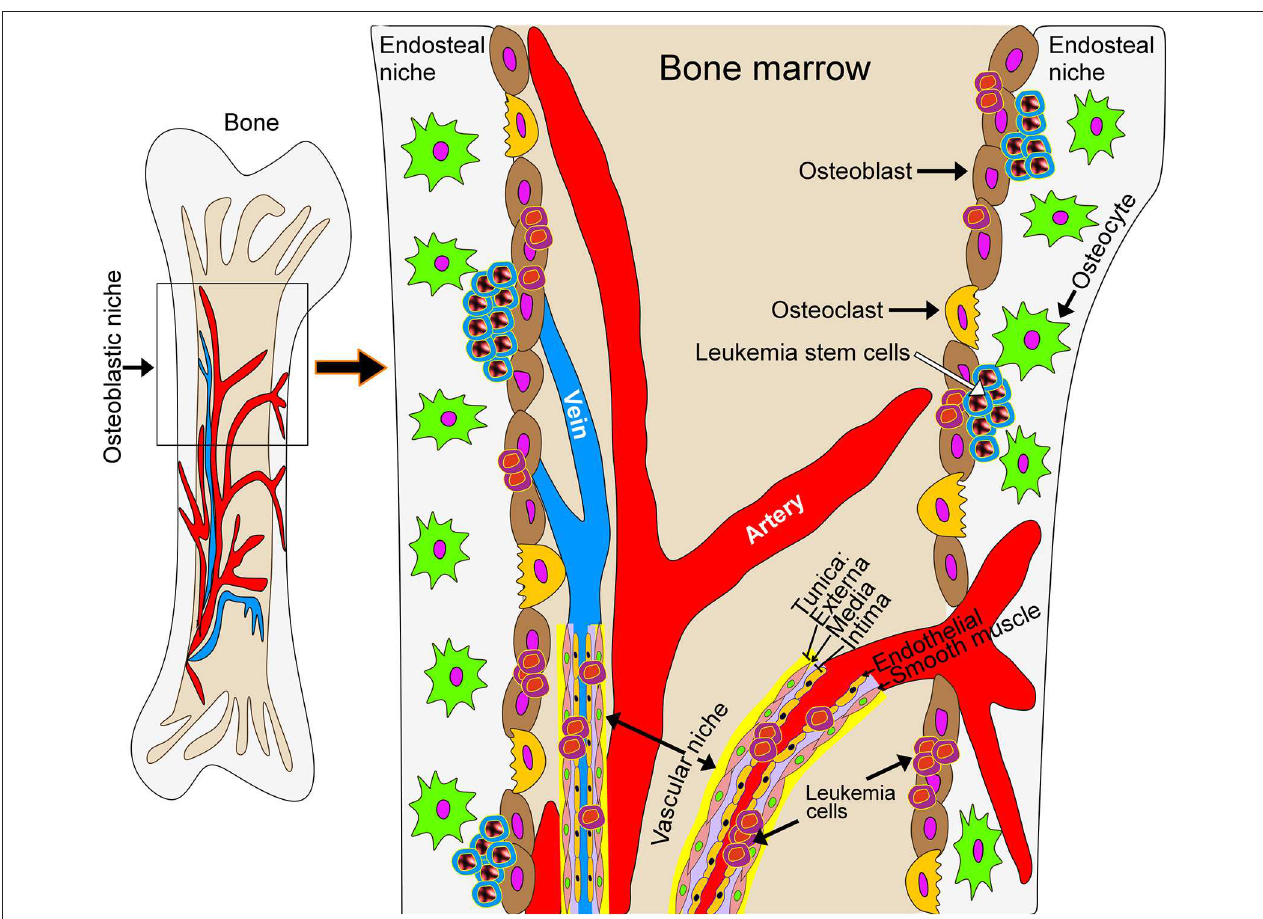
FIGURE 1 | Schematic model of the leukemic bone marrow niche. The microenvironment in the leukemic bone marrow niche contributes to disease progression, therapeutic response, evasion of therapy and the development of resistance to treatment. New treatment strategies may target the interaction of leukemic cells with stromal cells or with the extracellular matrix underlying bone